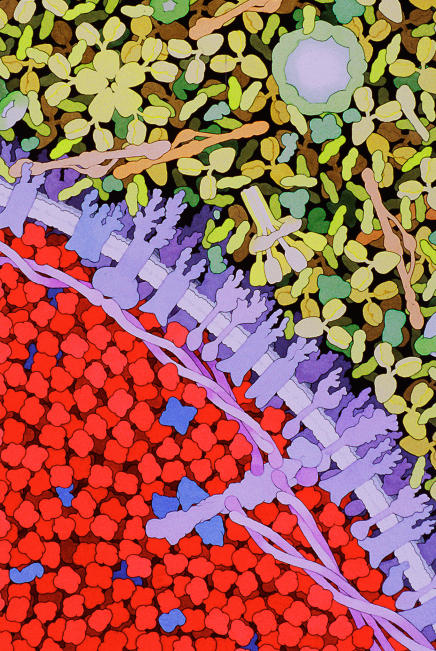
Cross Section through a Red Blood CellThe blood serum is shown at the top, the cell membrane crosses through the center, and the interior of the cell, packed with hemoglobin, is at the bottom. This illustration was created by David Goodsell for use in an online educational resource at the undergraduate college level.